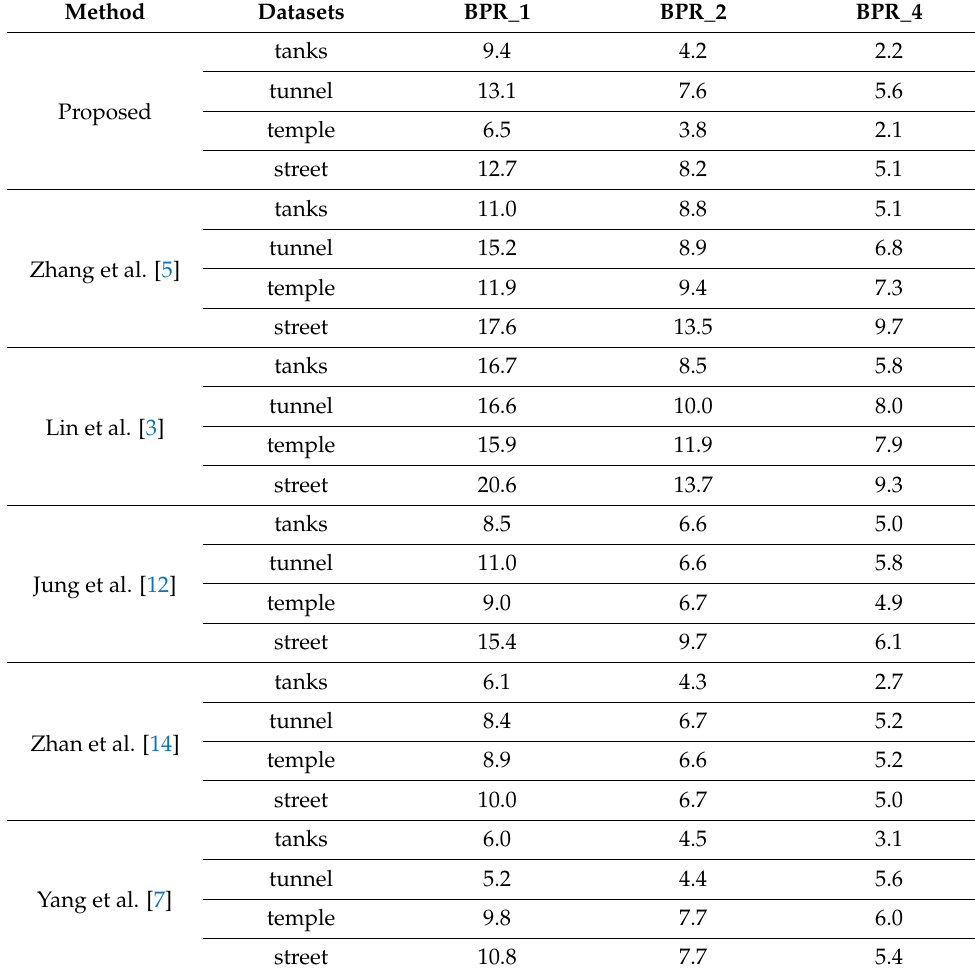
Table 3. Comparative results for average BPR_kn (%) values for datasets.